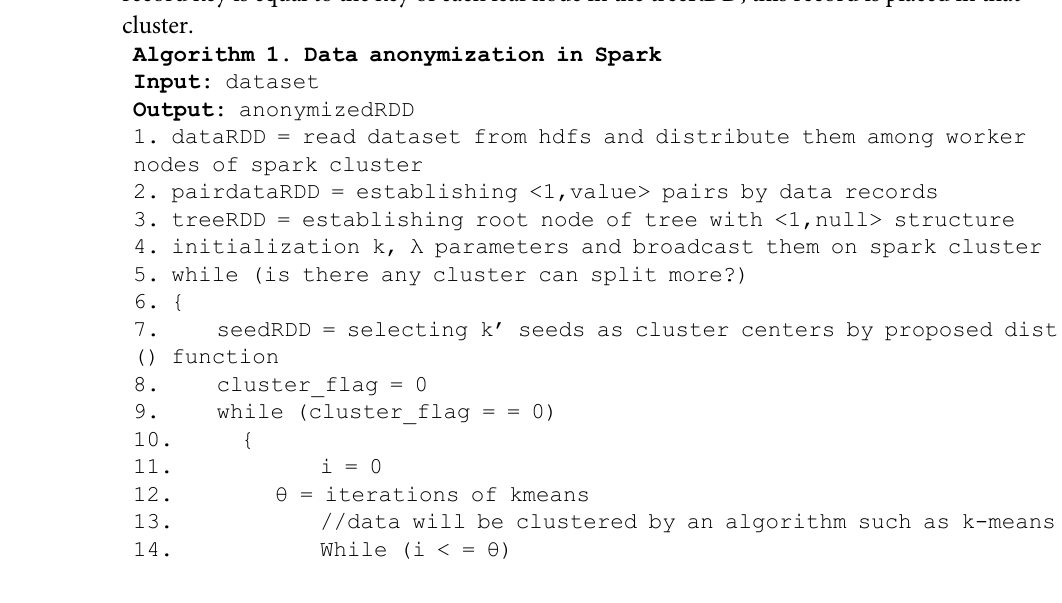
Algorithm 1. Data anonymization in Spark